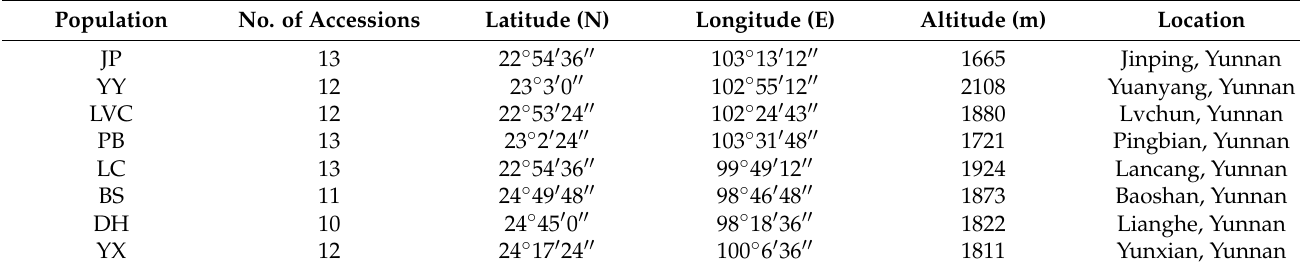
Table 1. Original information of Amomum tsao-ko accessions used in this study.